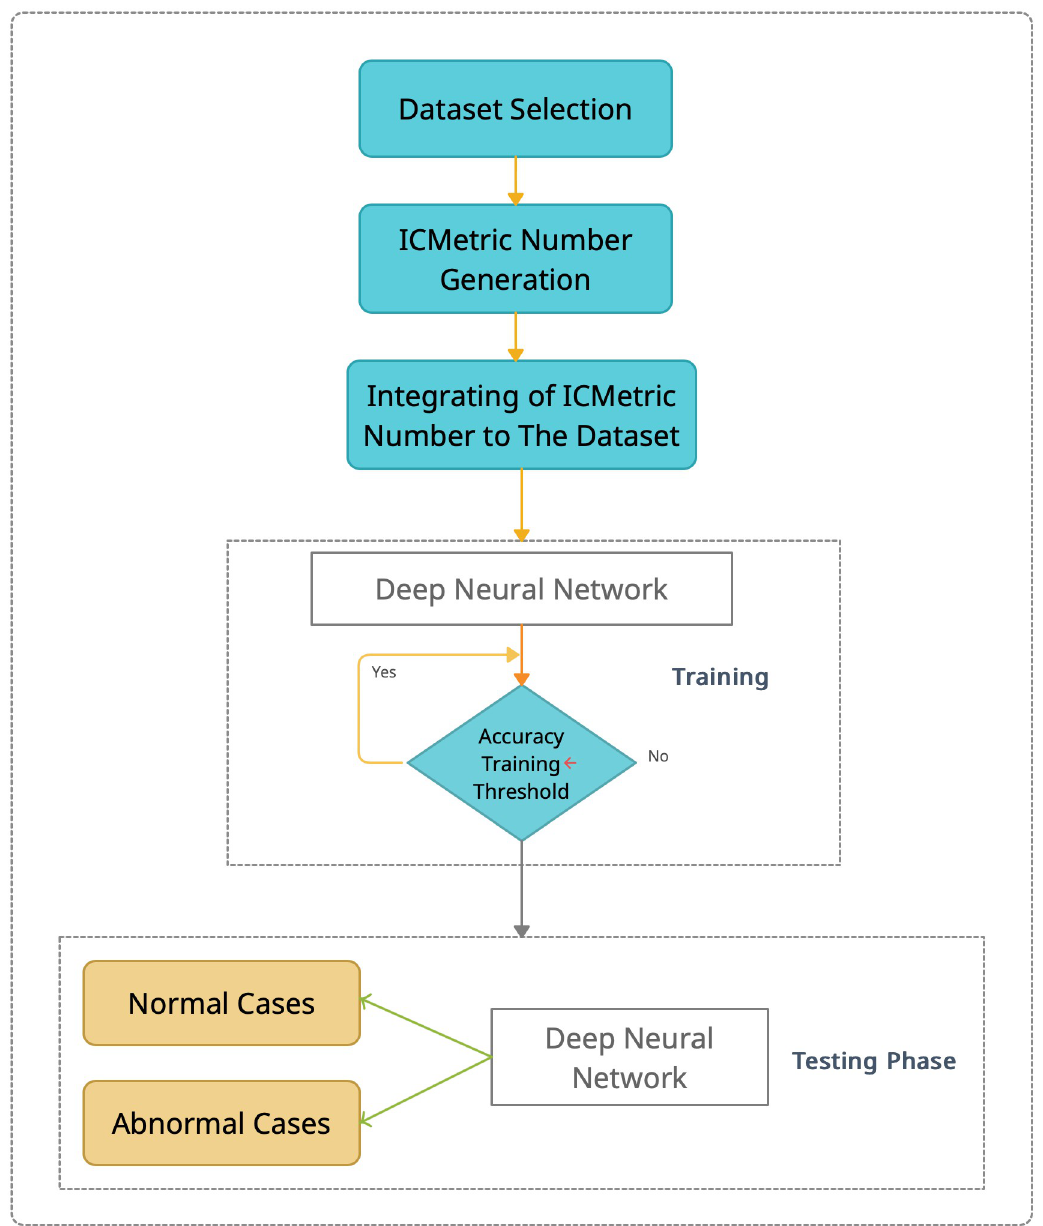
Fig 5. ICMetric system block